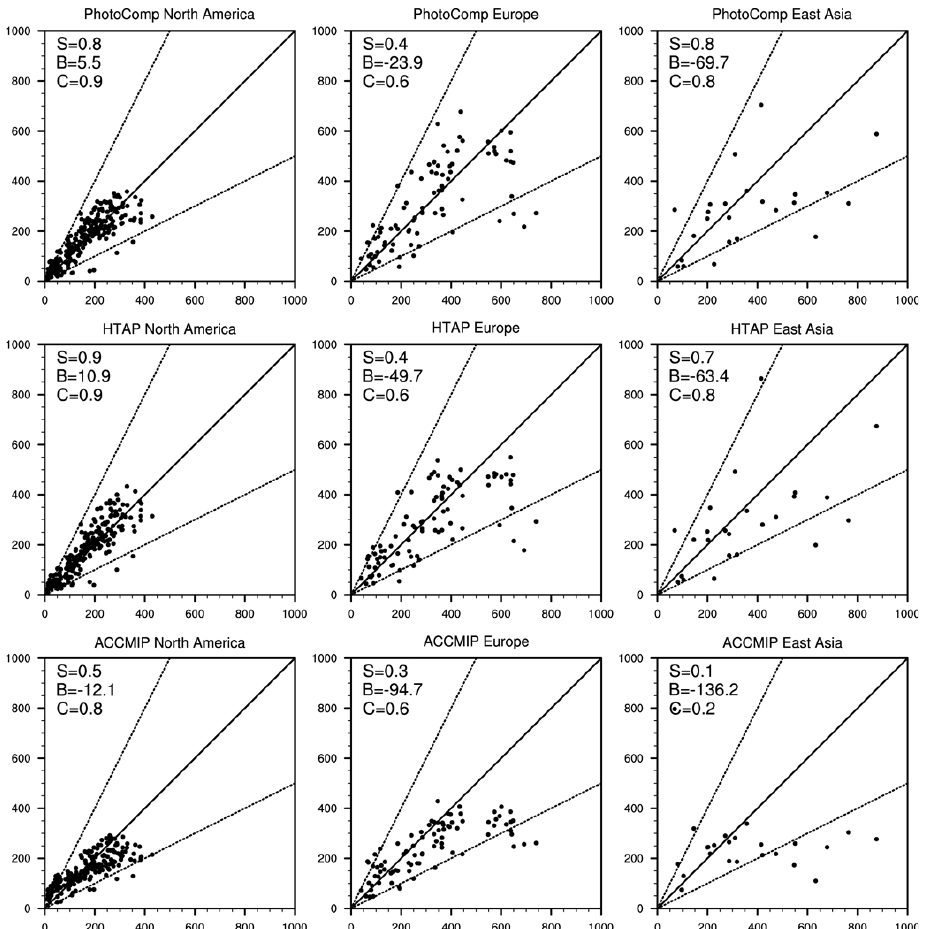
Fig. 2b. Scatter plot ( x axis: observations, y axis: multi-model mean) of ammonium wet deposition (mg(N)m − 2 yr − 1 ) over North America (left column), Europe (middle column) and East Asia (right column). Top row shows the model results from PhotoComp, middle row from HTAP and bottom row from this study. See text for details. S = slope, B = mean bias (mg(N)m − 2 yr − 1 ), and C = correlation (see Table 5).